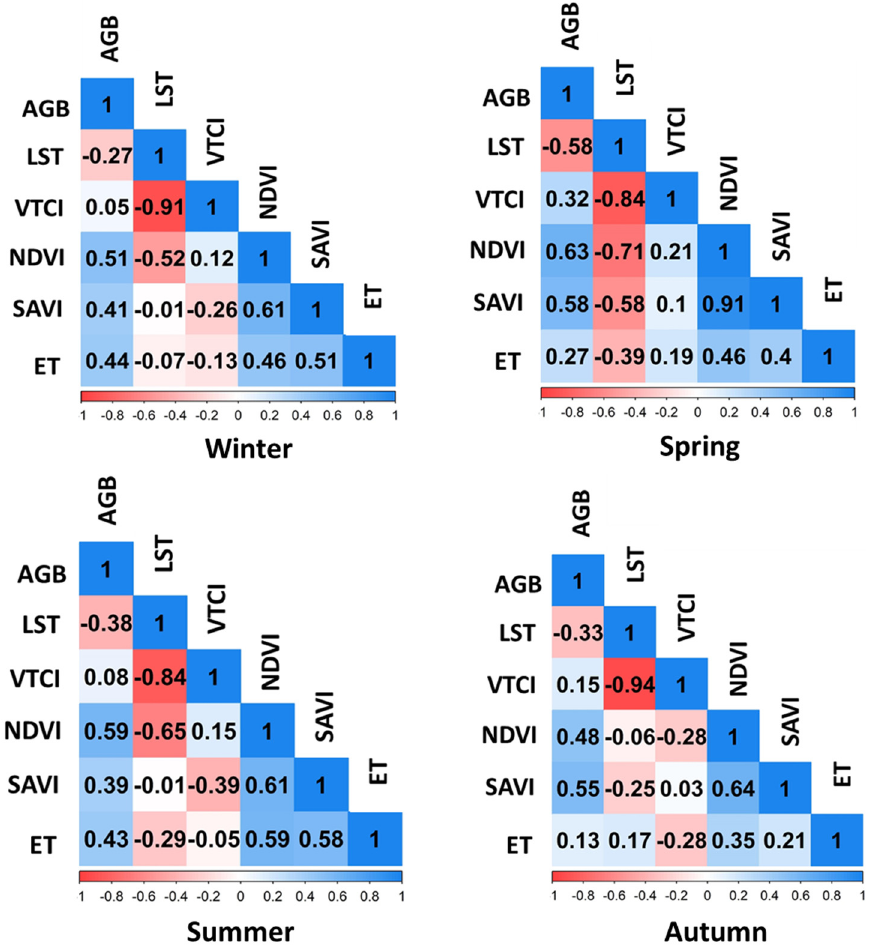
Figure 2. Pearson’s correlation between predictor spectral variables and above-ground biomass (AGB) in different seasons of the year. LST, Land Surface Temperature ( ◦ C); VTCI, Vegetation Temperature Condition Index; NDVI, Normalized Difference Vegetation Index; SAVI, Soil-adjusted vegetation index; ET, evapotranspiration (kg m − 2 ).